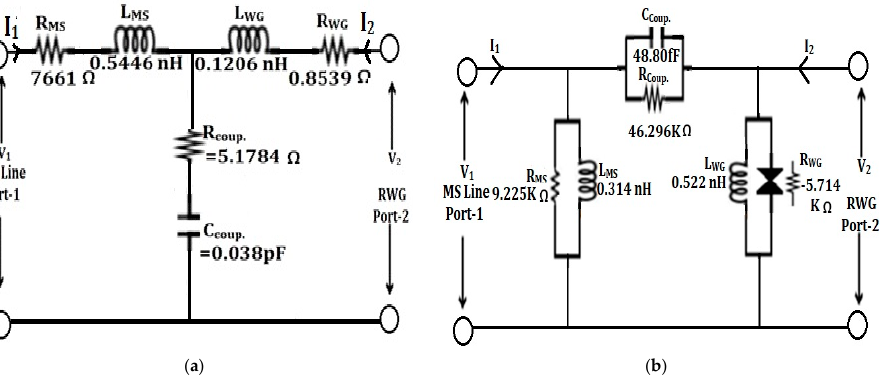
Figure 12. RLC electric equivalent circuit of E-plane microstrip-to-WR28 transitions at 30 GHz: ( a ) T-equivalent circuit, ( b ) π -equivalent circuit. 4.5. Comparison of the Proposed Work with the Existing Ka-Band RWG-to-MSL Transitions A parametric comparison of the performance results of the existing Ka-band MSL-toRWG transitions with the proposed Ka-band optimized design is shown in Table 6. Table 6. Ka-band Rectangular Waveguide to Microstrip Line Transition Design Results. Ref.